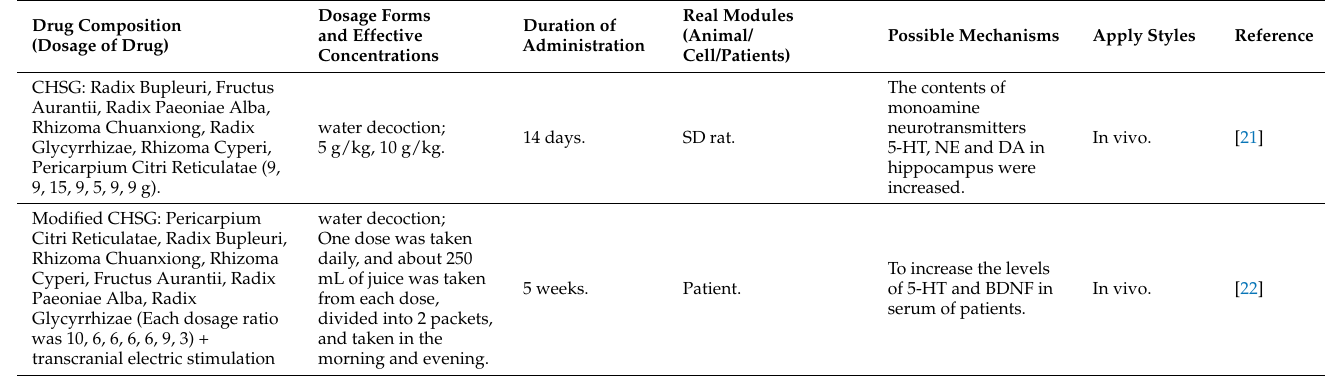
Table 3. Antidepressant effect and mechanism of